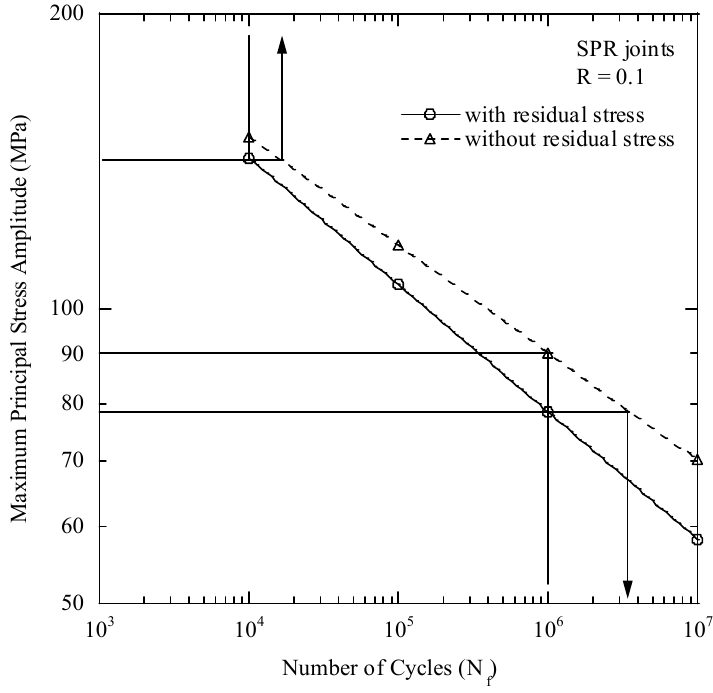
Figure 15. Effects of compressive residual stress on the fatigue lifetime of an SPR joint.